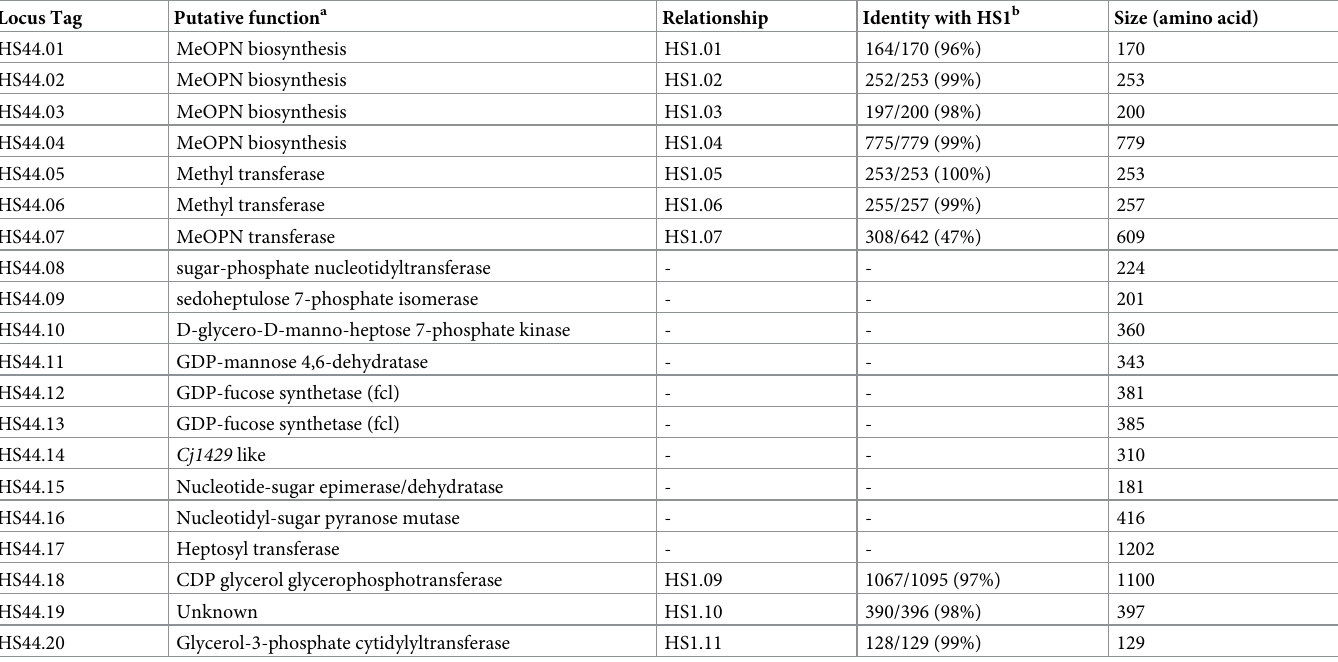
(a) Function attributed based on Blastp performed on non-redundant protein sequences database. (b) numbers In parenthesis are the percentage of identity between the HS1 and HS44